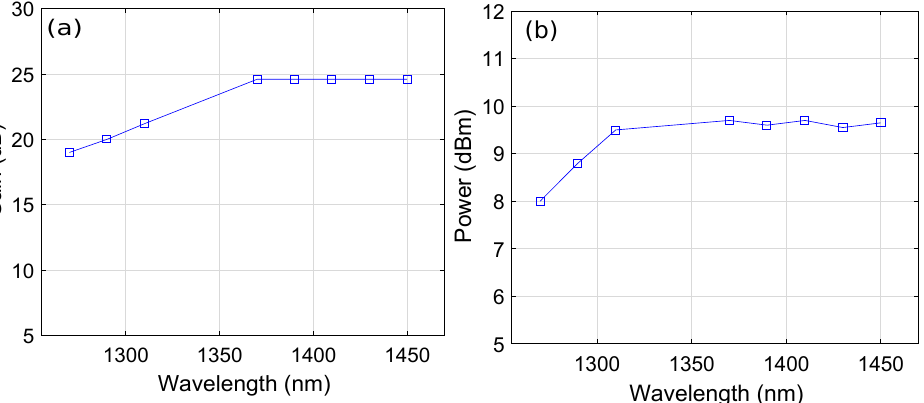
Figure 5. Wavelength versus ( a ) gain plots considering the up-conversion effect and ( b ) output power plots considering the up-conversion